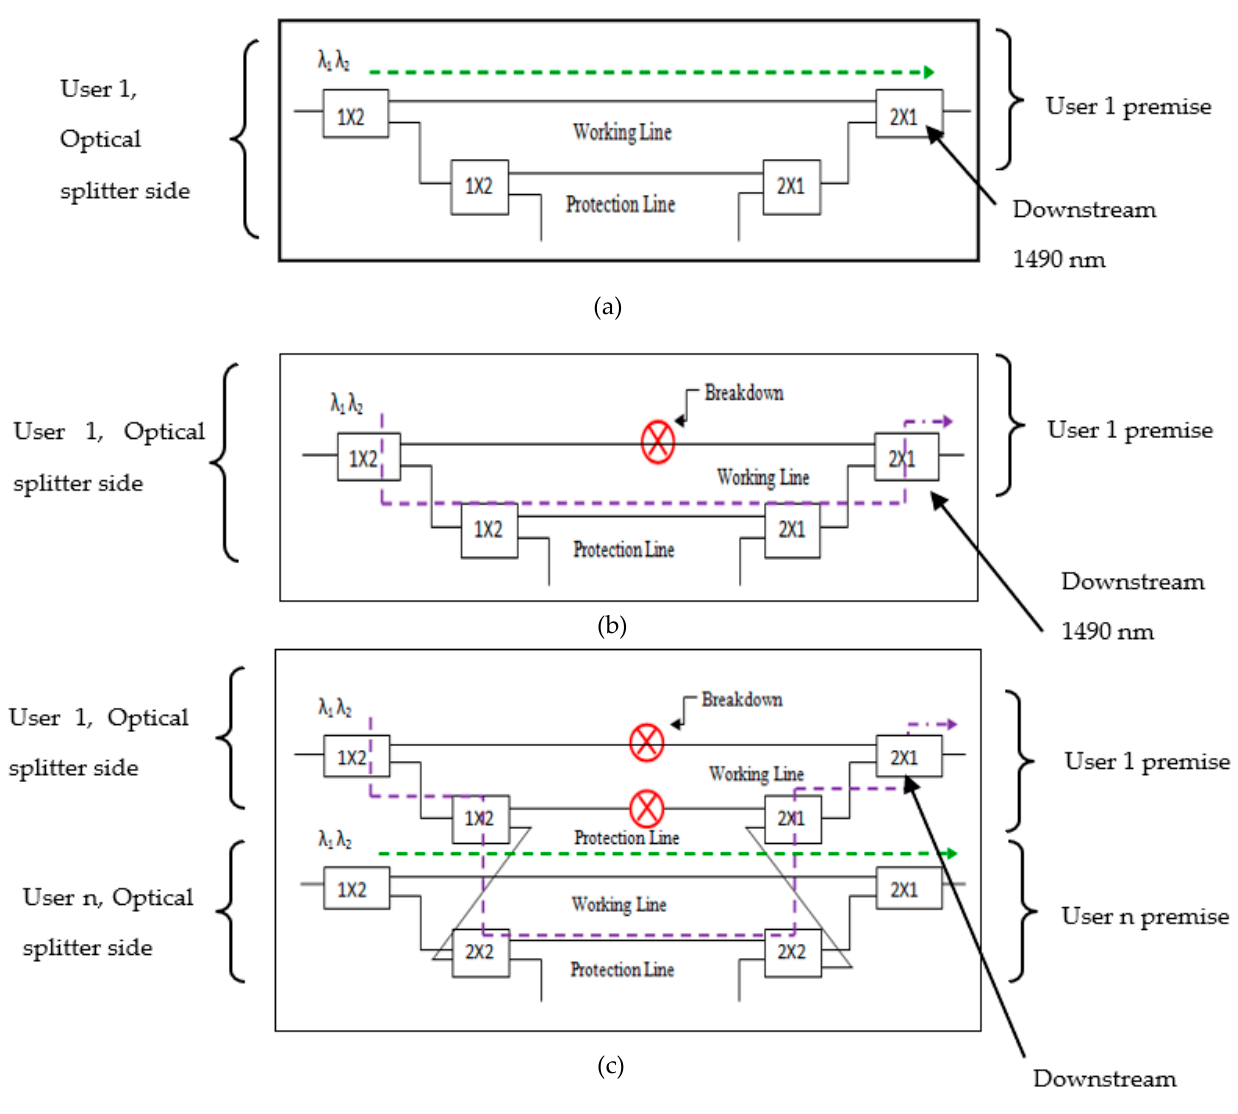
Figure 10. Conceptual ‘zig-zag’ protection and restoration scheme. ( a ) protection link ( b ) protection link ( c ) neighbor’s protection link.